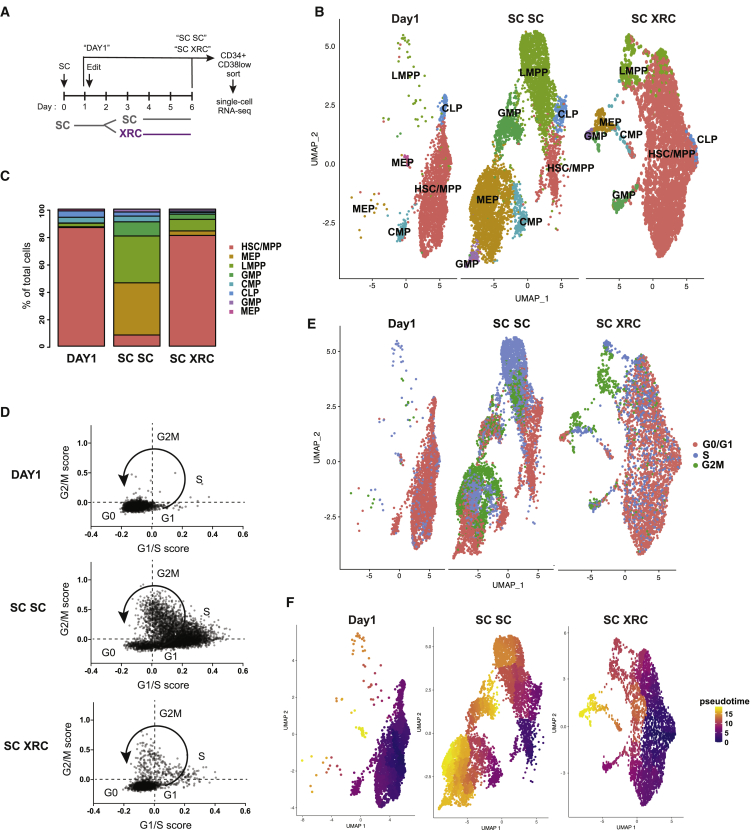
Single-Cell RNA Sequencing Indicates That XRC Treatment Leads to the Maintenance of Quiescent HSC/MPPs(A) Schematic of the workflow for single-cell RNA sequencing (scRNA-seq). CD34+ HSPCs are placed in SC culture for 1 day before editing and cycle for 2 additional days in SC culture, and then quiescence is induced with XRC for 3 days before the cells are subjected to FACS of CD34+CD38low cells and sequenced.(B) UMAPs of scRNA-seq using Seurat 3□s integrated analysis for day 1+SC SC and anchor transfer to SC XRC. Number of cells in day 1 = 2,454, SC SC = 5,686, and SC XRC = 3,595.(C) Fraction of cell assignments for each dataset.(D) Cell cycle status of single cells based on G1/S and G2/M scores.(E) Cell cycle status predicted through gene expression.(F) Pseudotime estimates with HSC/MPPs as the root showing the inferred differentiation of day 1/SC SC and SC XRC datasets.See also Figures S5 and 56 and Table S1.